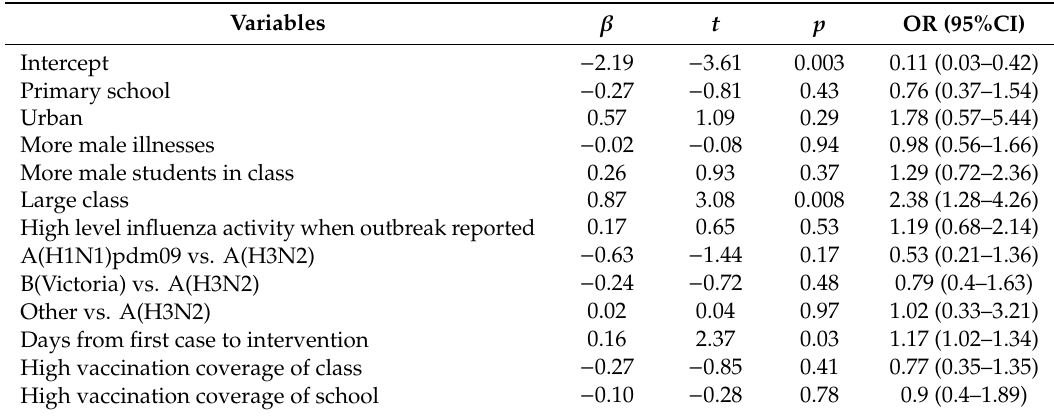
Table 2. Two-level logistic regression model comparing serious outbreaks and mild outbreaks in